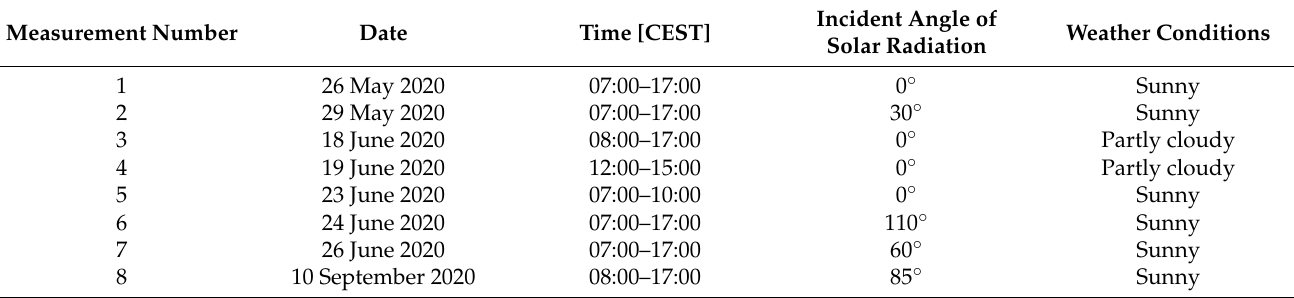
Figure 1 . All dosimeters mounted on the sun-tracking device on the roof of the Institute for Occupational Safety and Health, Sankt Augustin, Germany (left-hand side: electronic dosimeters X2012-10 V3 (above) and V1 (below); in the center: VioSpor blue line type III; right-hand side: Polysulphone film (PSF) dosimeters). Shading caused by buildings or trees was avoided. Table 1. Measurement parameters for determined measurement scenarios. Incidence of 0° refers to parallelity to the surface normal of the detector, while all other angles also refer to the surface normal. At 110°, the sun does not shine directly onto the dosimeters. Measurement times refer to Central European Summer Time (CEST).